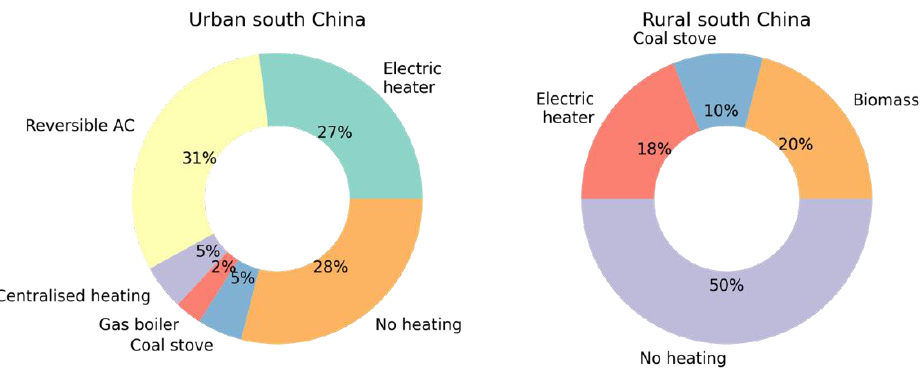
Figure 4. Heating situations in urban and rural south China.